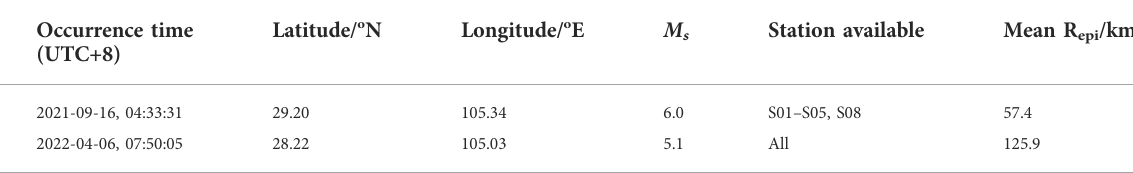
TABLE 2 Parameters of strong motion